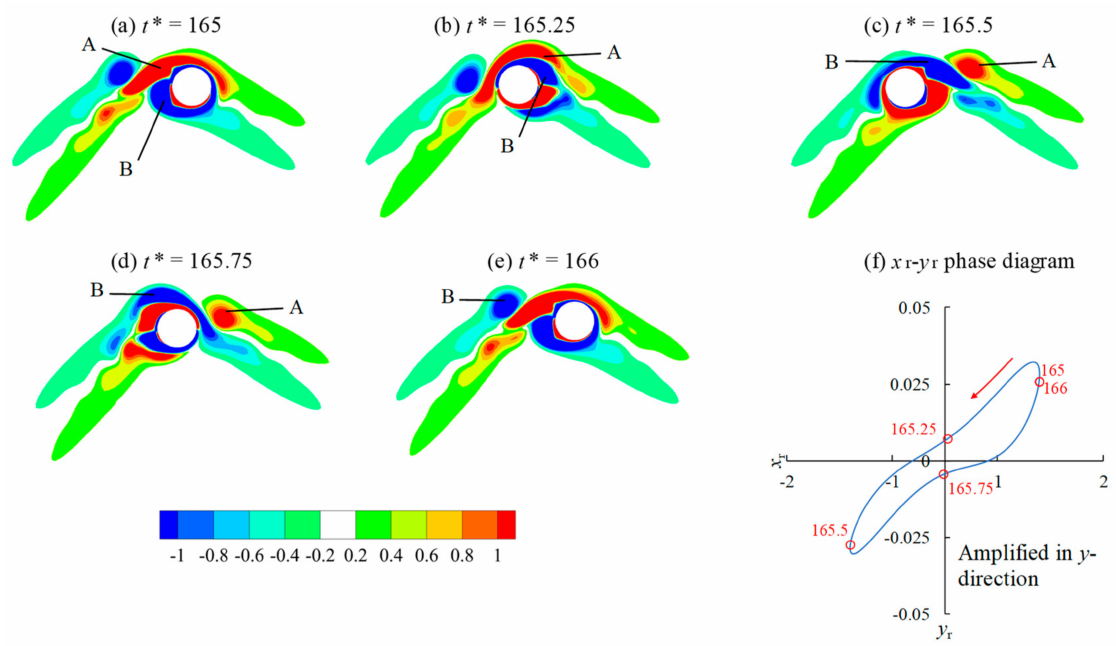
Figure 10. Regime R at β = 45 ◦ , KC = 10, f ∗ = 1 within one period starting from t ∗ = 360. ( a )–( e ) Contours of vorticity of ( f ) x r - y r phase diagram.